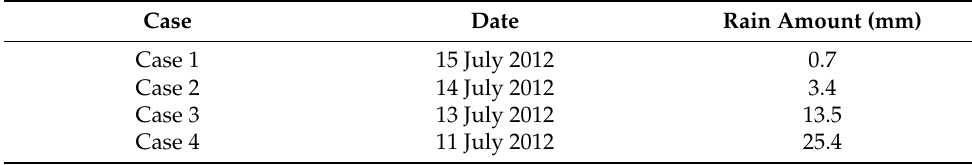
Table 1. Selected date and rain